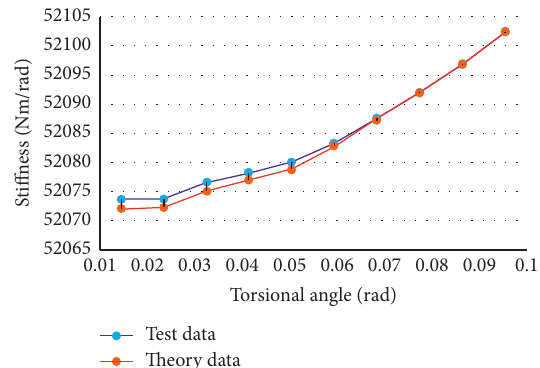
Figure 18: Recognized coupling stiffness and its theoretical result.